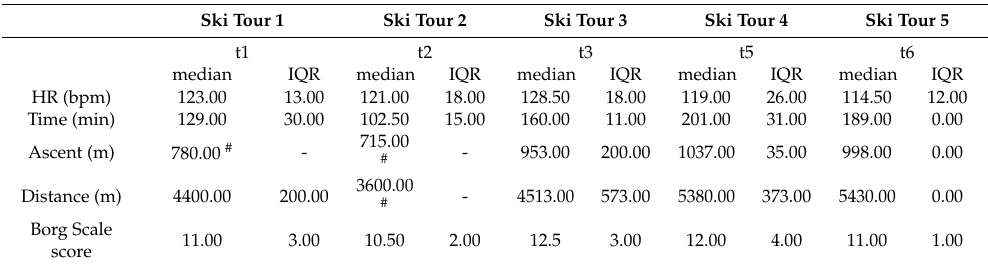
Table 1. Descriptive route information, heart rate and Borg Scale scores of recreational ski mountaineers. Ski Tour